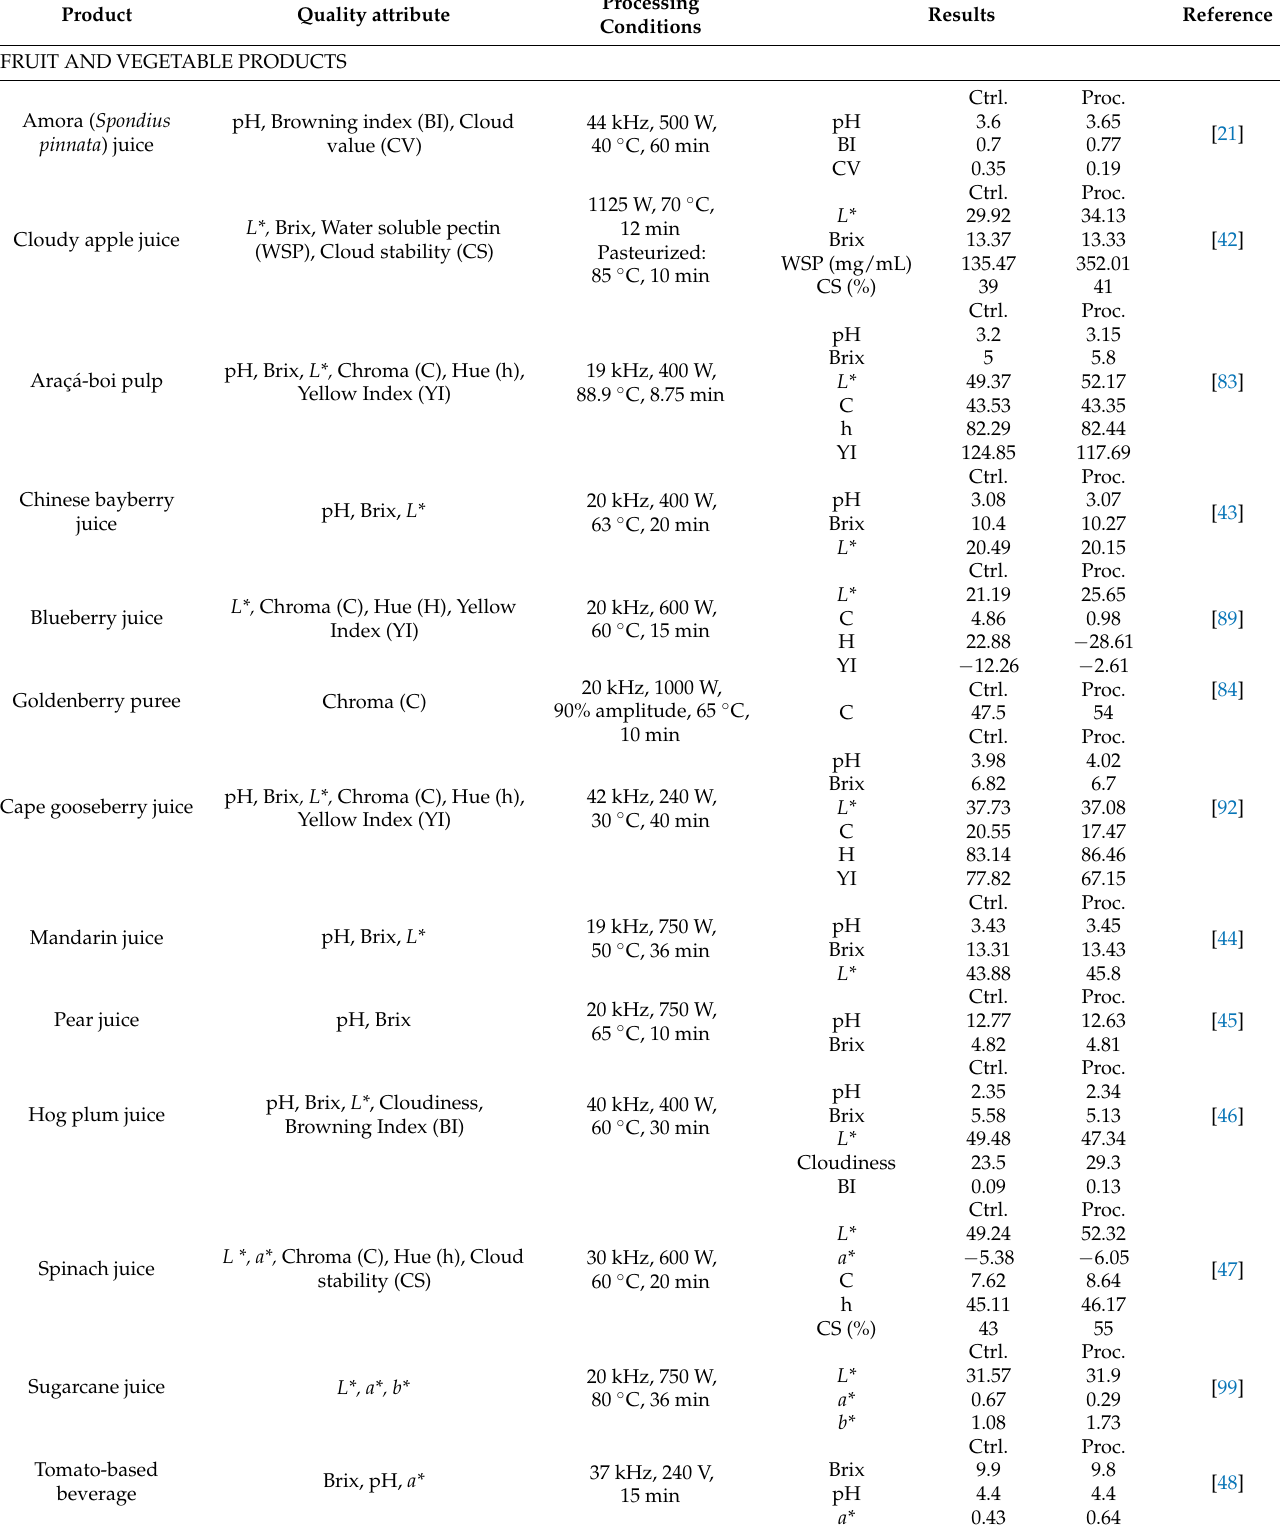
Table 4. Quality changes in food products after ultrasound